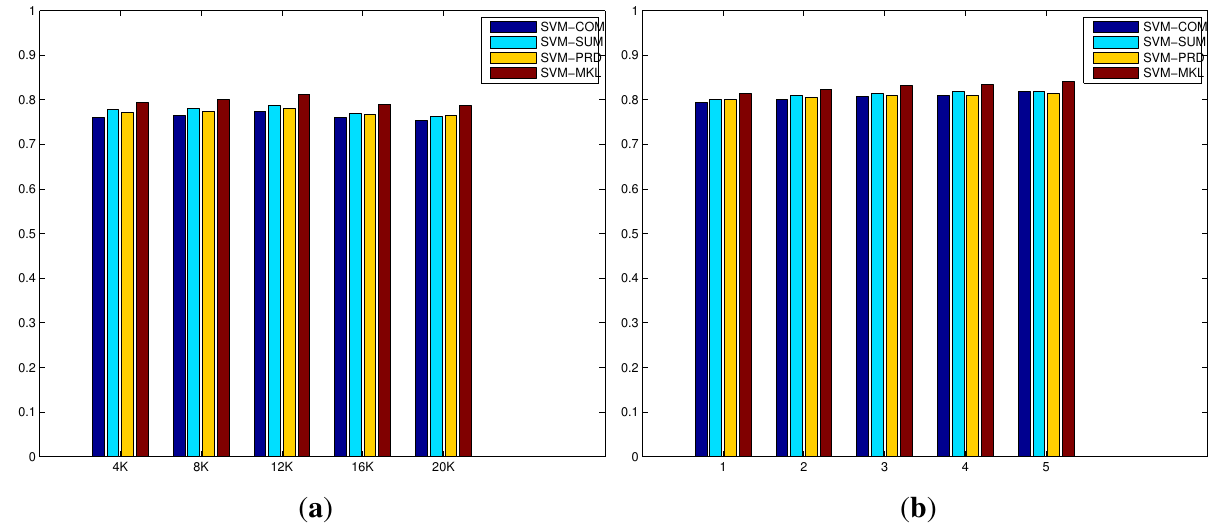
Figure 5. Performance comparisons on the IXMAS actions dataset, of proposed methods, with respect to the size of BoWs (from 4 K to 20 K when the number of layers of mSDA is 5) and the number of layers of mSDA (from 1 to 5 when the size of BoWs is 4 K), in terms of average recognition rates. ( a ) The size of BoWs; ( b ) The number of layers of mSDA. Table 2. Comparison of all the methods in this work using IDT descriptor and BoWs or mSDA on the IXMAS actions